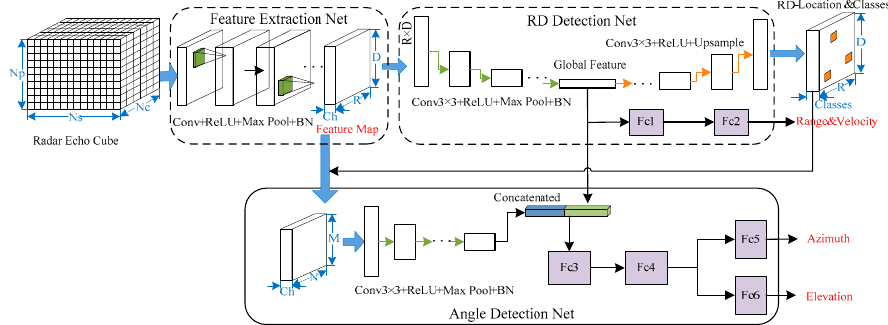
Figure 11. Structure of a CNN detector for RTD with radar echo data.